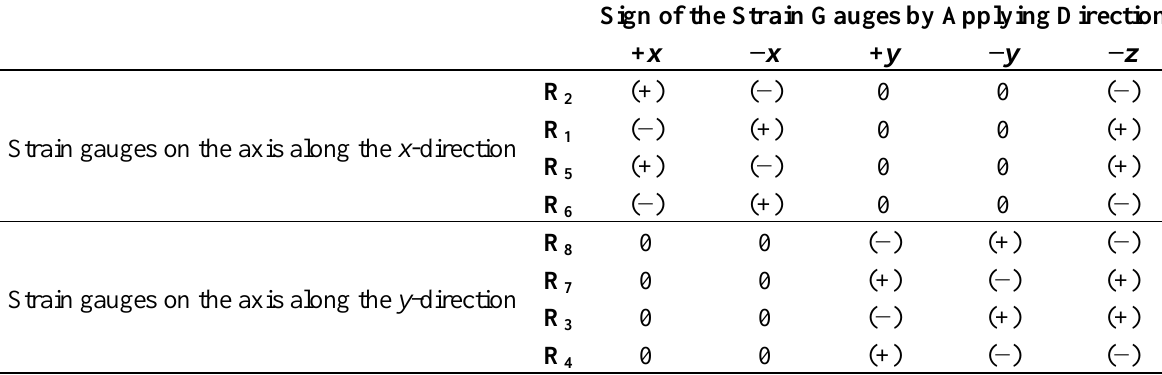
Sign of the Strain Gauges by Applying